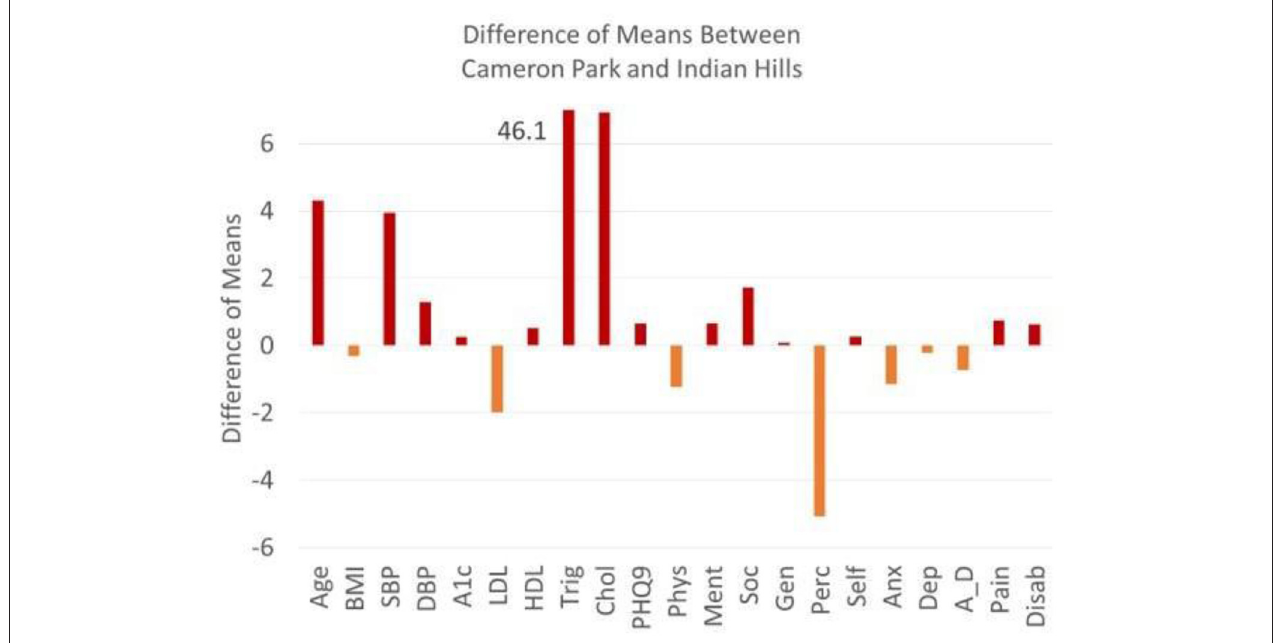
FIGURE 1 | Differences between means between cameron park and Indian hills. The plot of the difference of means as calculated by hoteling T2 is the squared difference of mean vectors scaled against the co-variance matrix for age (yrs), BMI, SBP (systolic blood pressure), DBP diastolic blood pressure), A1c (HbA1C), LDL, HDL, Trig (Triglycerides), Chol (Cholesterol), PHQ9, physical health, mental health, social health, general health, perceived health, self-esteem, anxiety, depression, anxiety-depression, pain, disability. Above zero reflects a higher Cameron Park (red) and below zero reflects a higher Indian Hills Value (orange). Triglyceride means do not fit on the graph and are defined by the means across